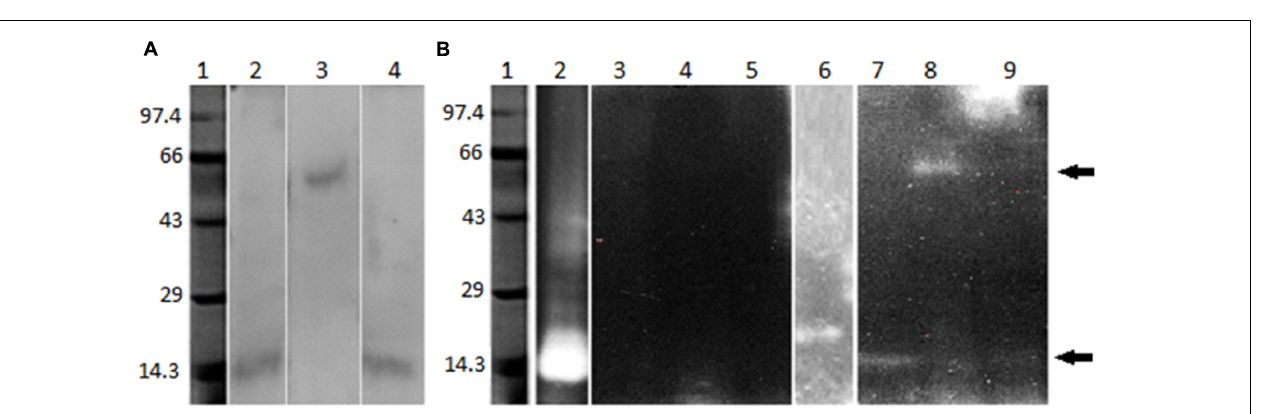
FIGURE 5 | Visualization of midgut bacterial proteases. Sephadex G-75 column eluted bacterial protease (5 µ g) were electrophoresed on 10% SDS-PAGE. After electrophoresis the gel was incubated in the trypsin or chymotrypsin assay buffer as described in text. Bacterial protease bands were visualized